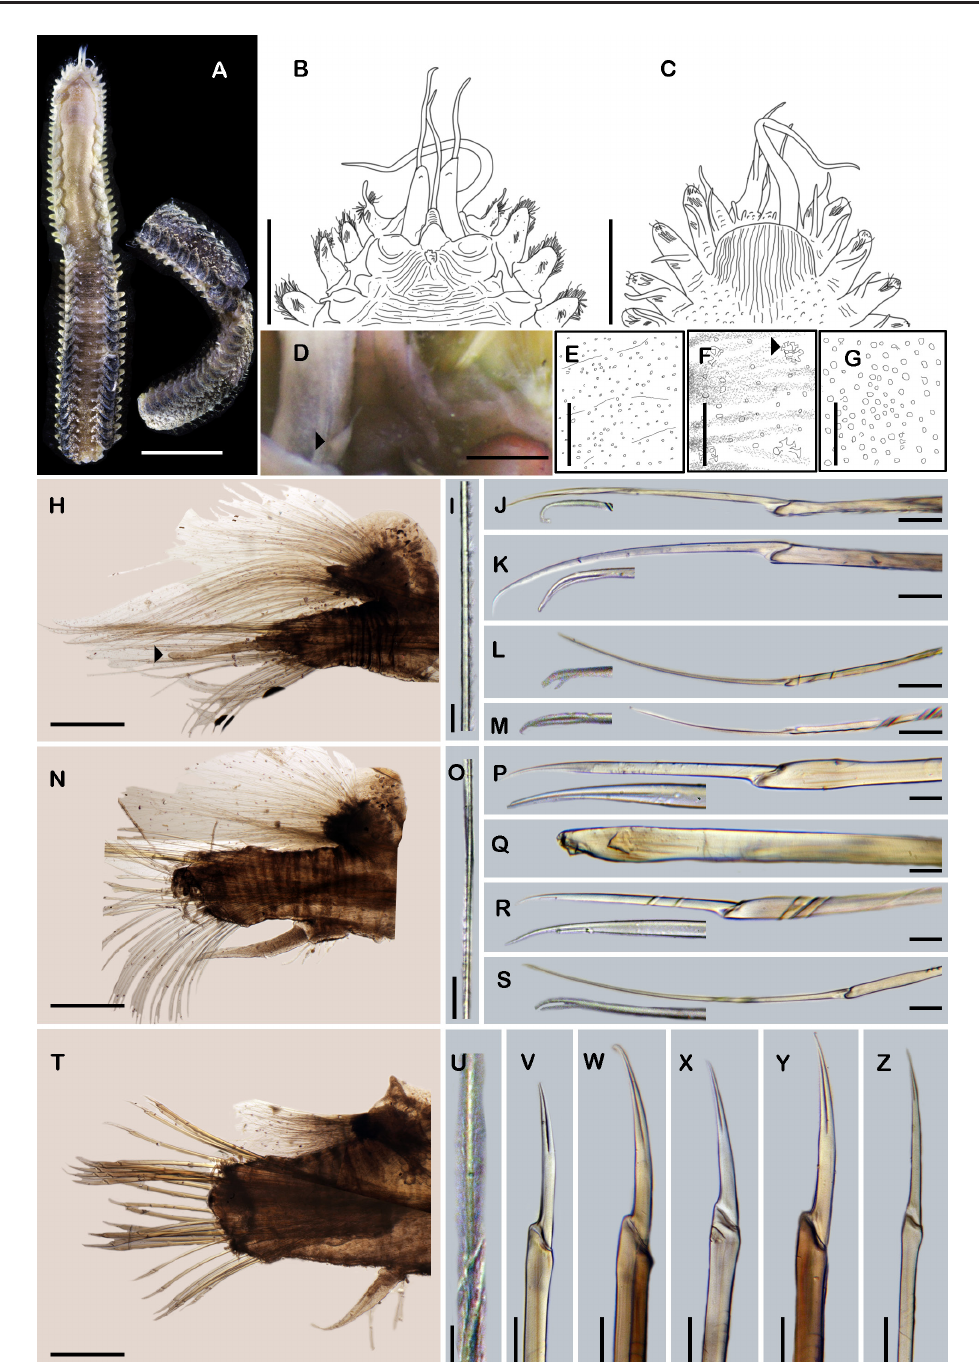
Fig. 23. Psammolyce flava Kinberg, 1856, non-type specimen (UMML 6720-927). A . Incomplete fragmented worm, dorsal view. B . Anterior end, dorsal view. C . Anterior end, ventral view. D . Detail of anterior end, arrowhead indicates lateral antennae. E . Dorsal papillae on anterior end. F . Dorsal papillae on middle region; arrowhead indicates right lateral antenna. G . Ventral papillae. H . Right parapodium from segment II, arrowhead indicates neuropodial appendage. I . Notochaeta from same. J . Unit A. K . Unit B. L . Unit C. M . Unit D. N . Right parapodium from segment III. O . Notochaeta from same. P . Unit A. Q . Unit B, blade missing. R . Unit C. S . Unit D. T . Right parapodium from segment 23. U . Notochaeta from same. V . Unit A. W . Unit B. X . Unit C. Y . Subunit 1. Z . Unit D. Scale bars: A = 1 cm; B–C = 2 mm; D, H, N, T = 500 μm; E–G = 100 µm; I, O, U = 40 μm; J–M, P–S, V–Z =